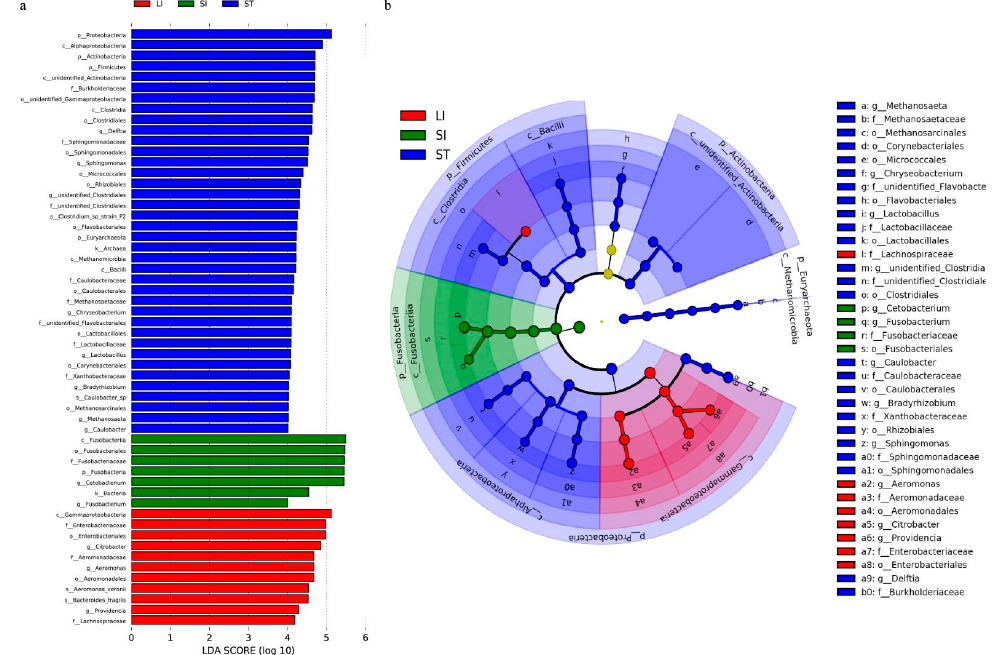
Figure 6. Biomarker analysis of microbial communities from the different segments of the gastroin- testinal tract. ( a ) Differentially abundant taxa. The length of the histogram represents the impact of the different species (LDA > 4). ( b ) Cladogram showing the phylogenetic structures of the microbi- ota. Abbreviations: LI, large intestine; SI, small intestine; ST, stomach.